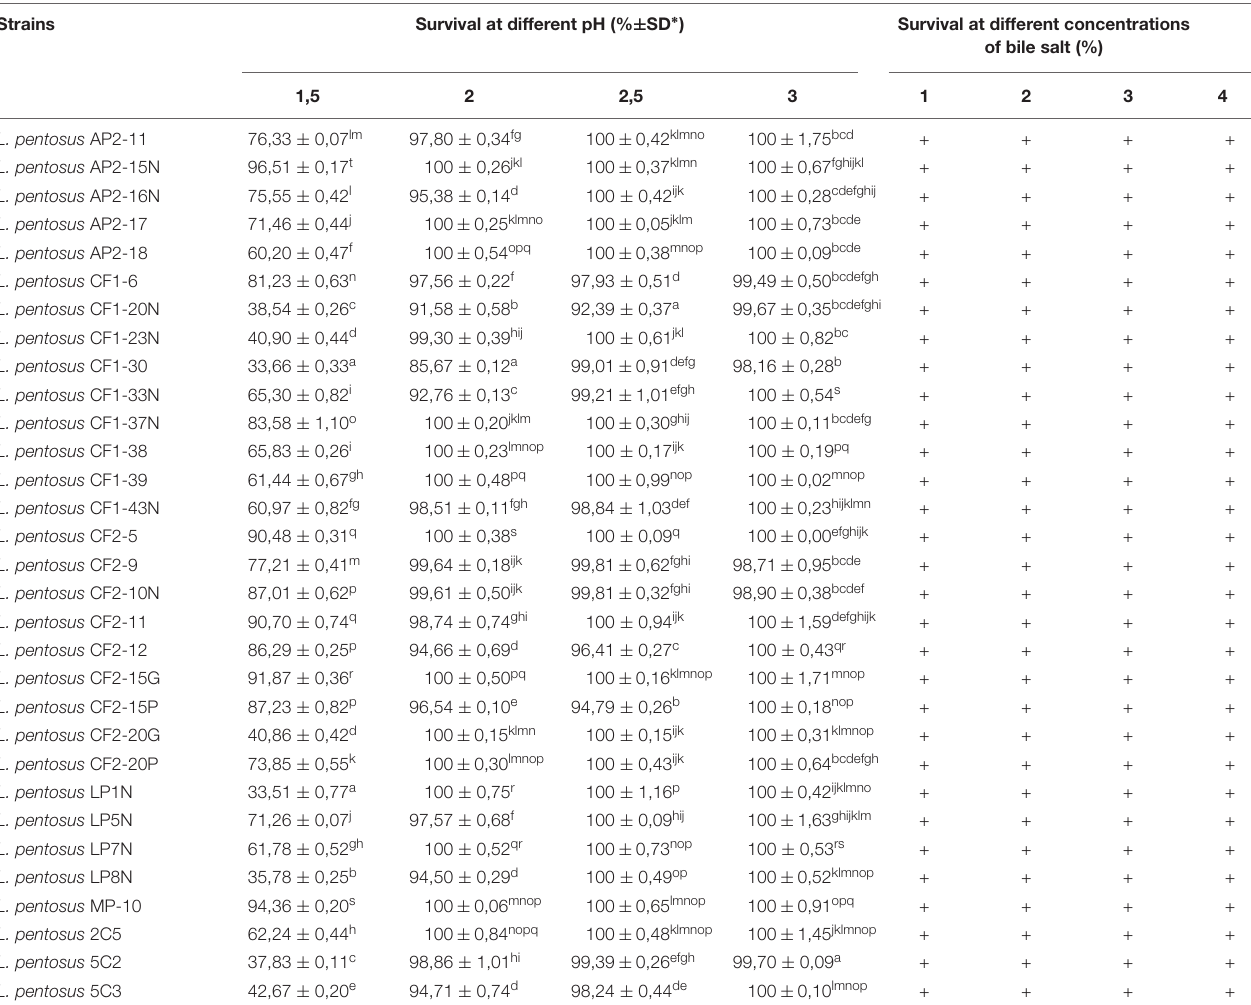
TABLE 1 | Survivability of Lactobacillus pentosus strains under gastric conditions.